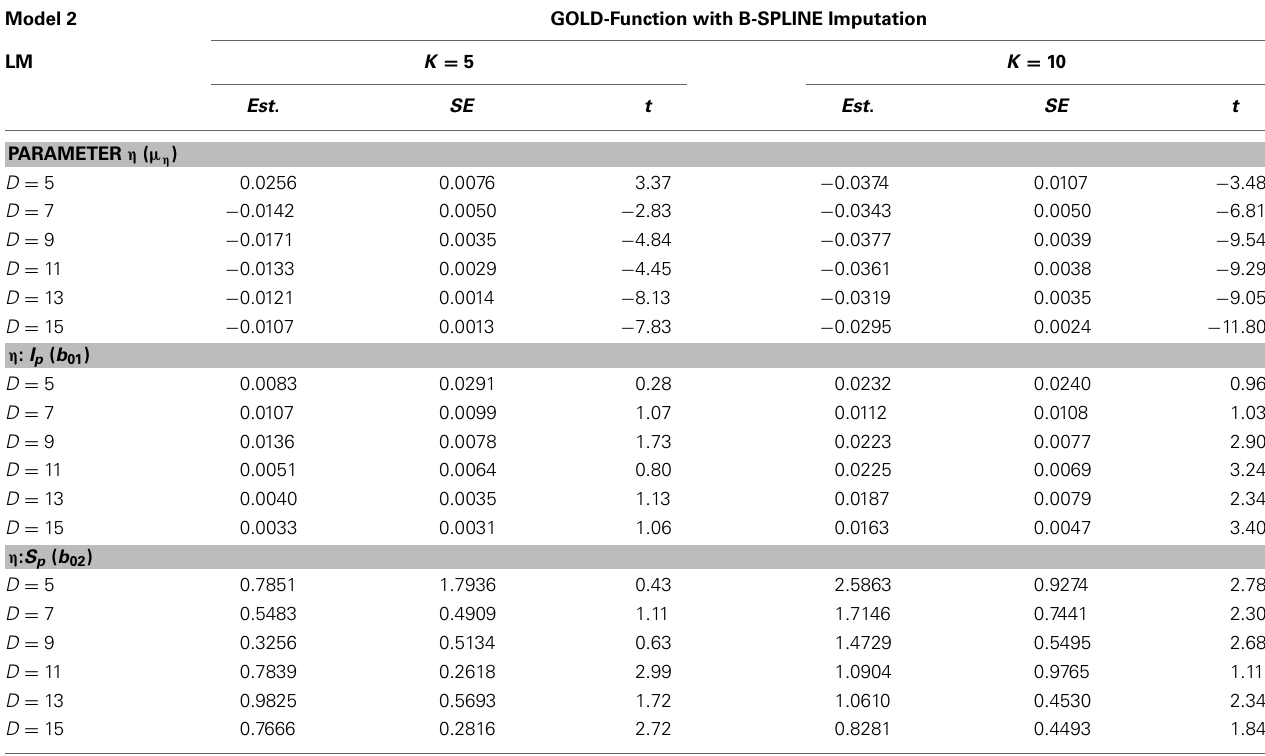
Table 2 | Estimated fixed effect of parameter η predicted by intercept and slope using Model 2 applied on B-spline imputed data. Model